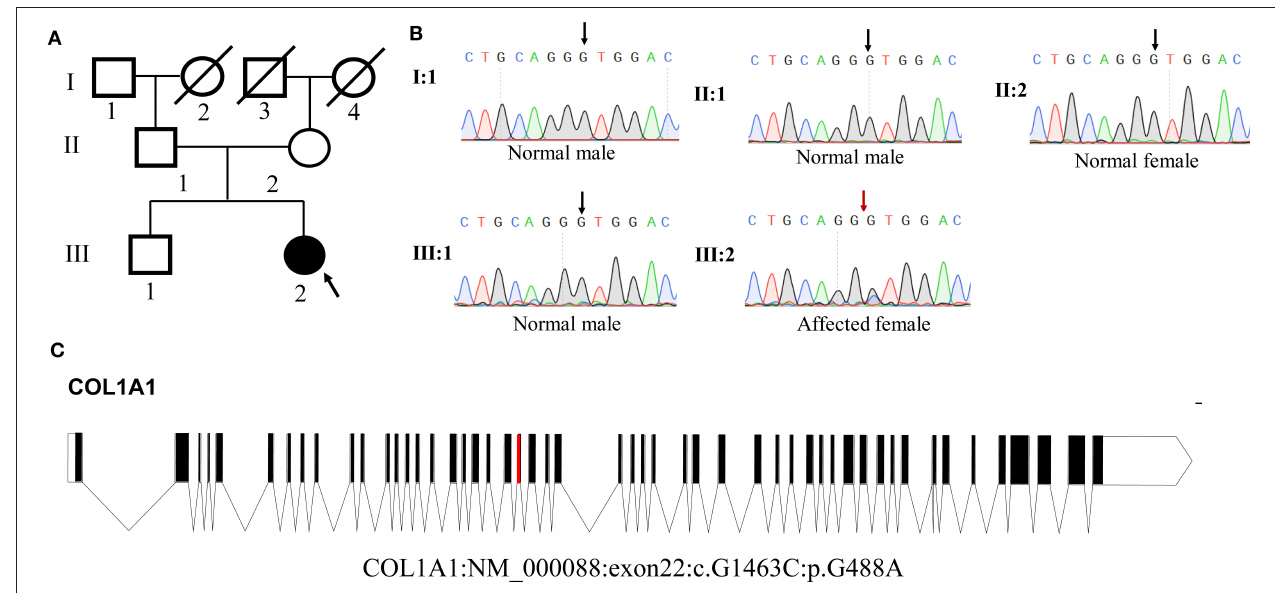
FIGURE 3 | Analysis of COL1A1 mutation. (A) Pedigree of the family. (B) Sequence chromatogram of the affected individual (heterozygous) and control (wild type). (C) Genomic structure of COL1A1 . The rectangles represent exons.